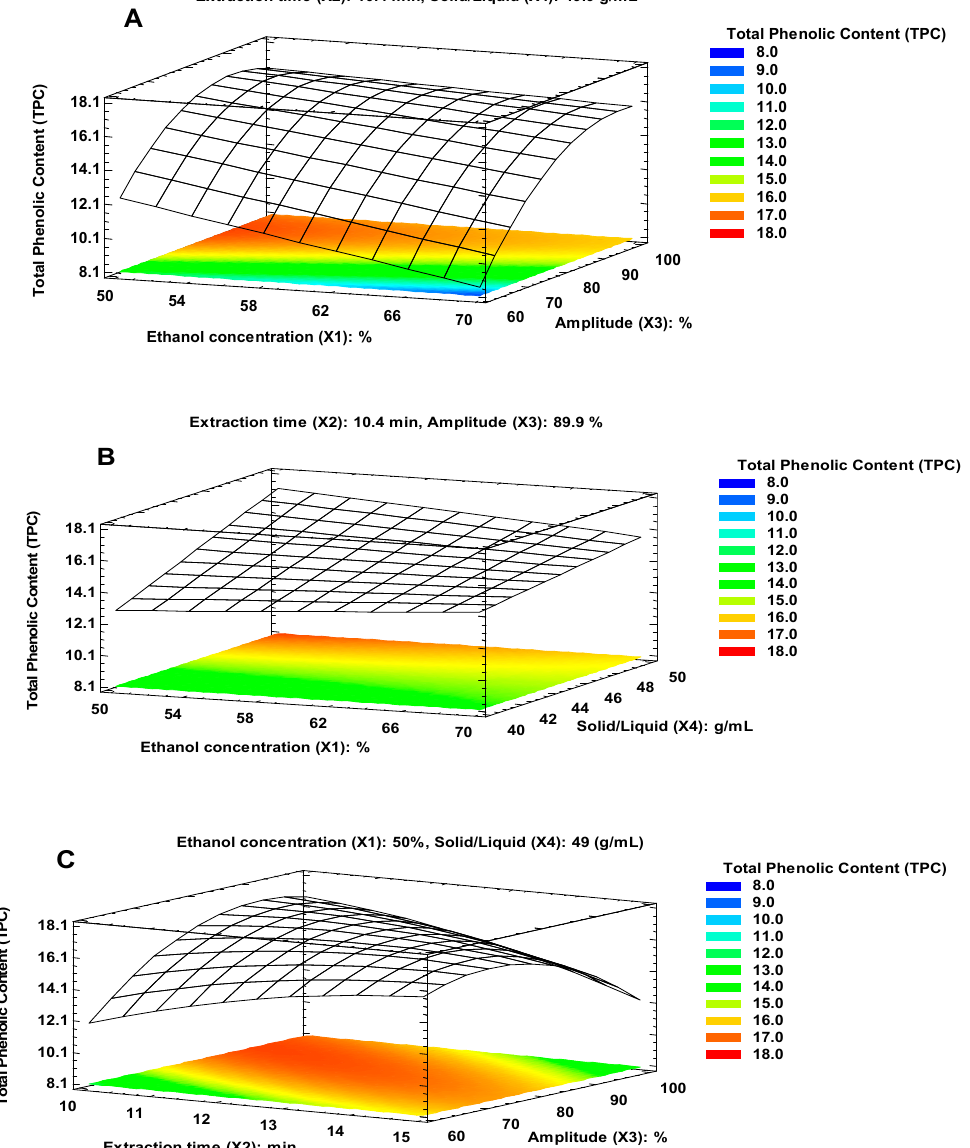
Figure 1. Response surface plots showing the interaction effects over TPC recovery by varying two factors, keeping the other two factors at a constant point. ( A ) Ethanol Concentration-Amplitude (X 1 X 3 ); ( B ) Ethanol concentration-solid/liquid ratio (X 1 X 4 ); ( C ) Extraction Time-Amplitude (X 2 X 3 ).